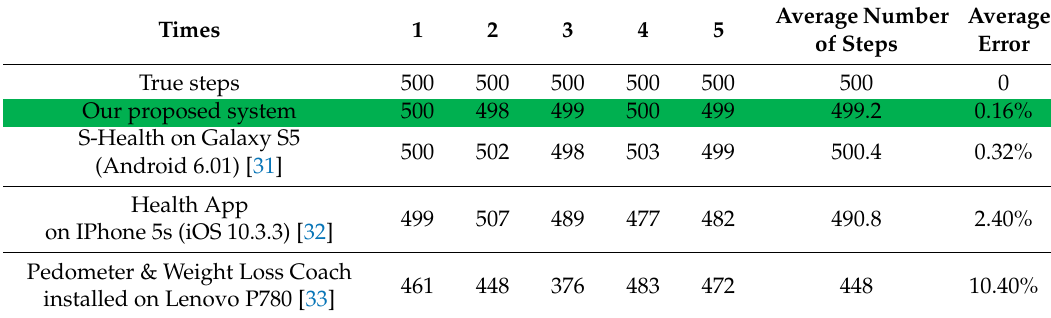
Table 6. Comparisons between our proposed system with different commercial applications on 500 steps of free walking.